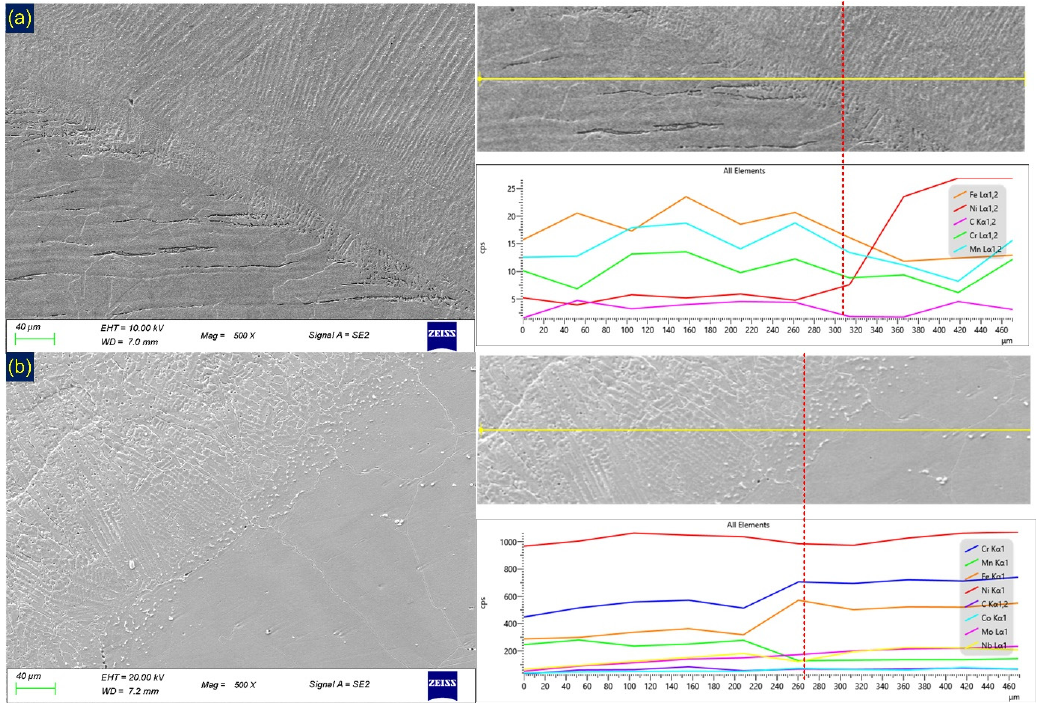
Figure 5. Interface and line map ( a ) across the interface of 304L SS, ( b ) across the interface of IN718 alloy.